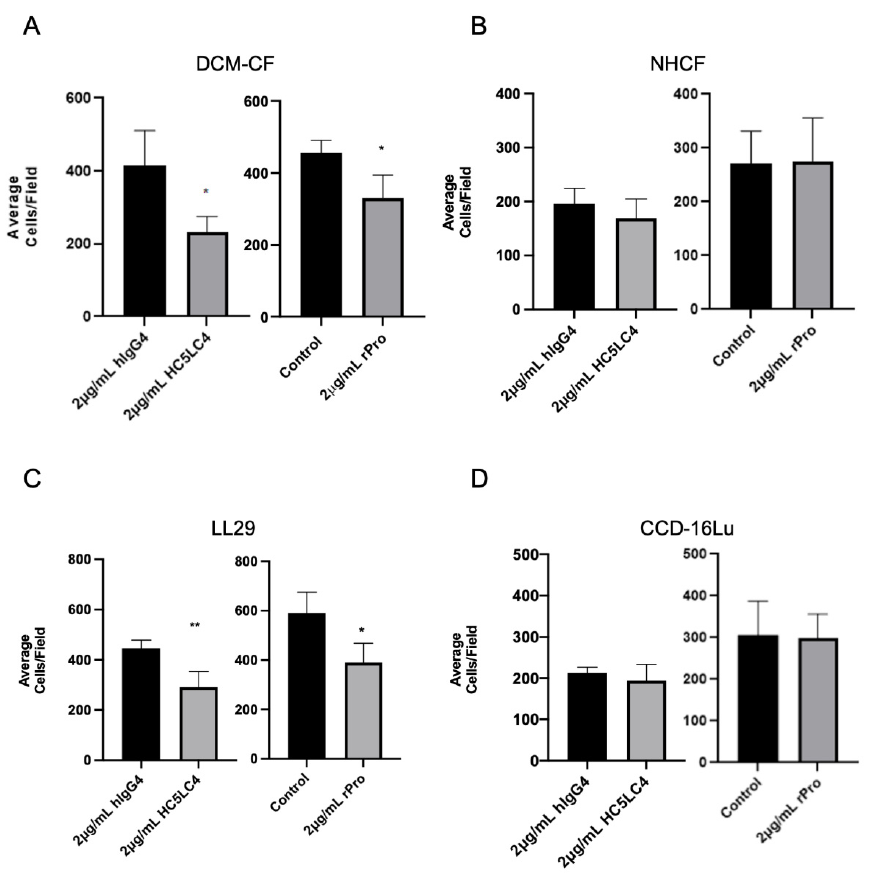
Figure 6. Cell surface PNC has a role in myofibroblast migration. Transwell permeable supports with a 6.5 mm polycarbonate membrane and 8 µ m pores were coated with human fibronectin and used to separate the upper and lower chambers of a 24-well cell culture plate to measure migration of cells across the membrane ( n = 4). Pathological myofibroblast migration is significantly reduced